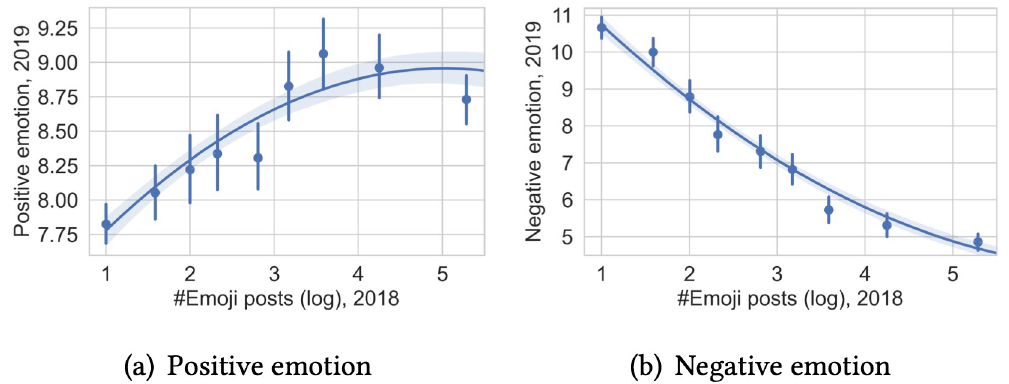
Fig 7. Emotion expressed via emojis in 2019 is related to the number of emoji posts in 2018. (a): Positive emotion. (b): Negative emotion.